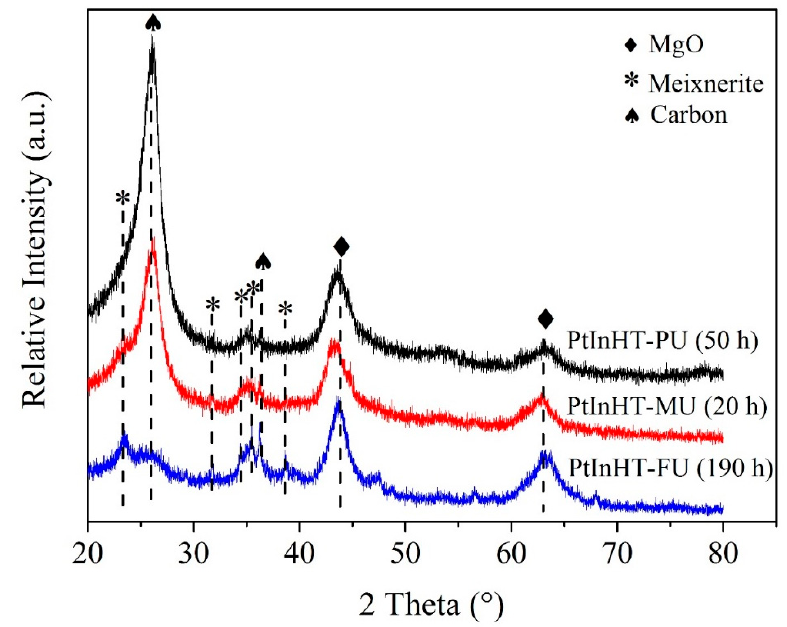
Figure 7. XRD patterns of used catalysts with different reaction time.